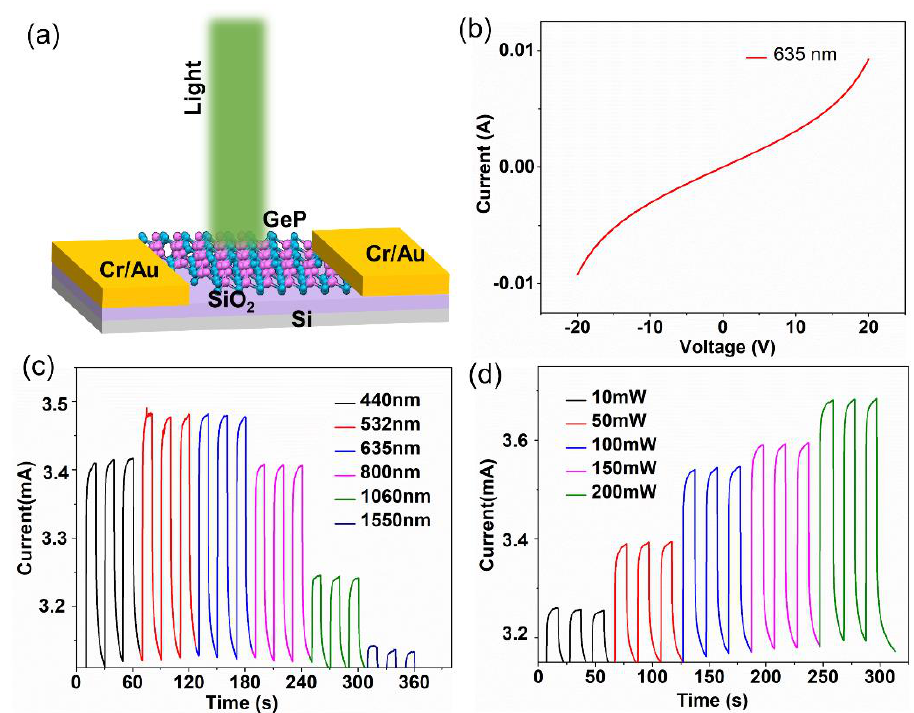
Figure 9. ( a ) Schematic of GeP photodetector. ( b ) Current – voltage (I – V) curve under 635 nm inci- dent light. ( c ) Time-resolved photocurrent of the GeP photodetector under 440 – 1550 nm incident light. ( d ) Time-resolved photocurrent of the GeP photodetector under different incident power for 635 nm incident light.